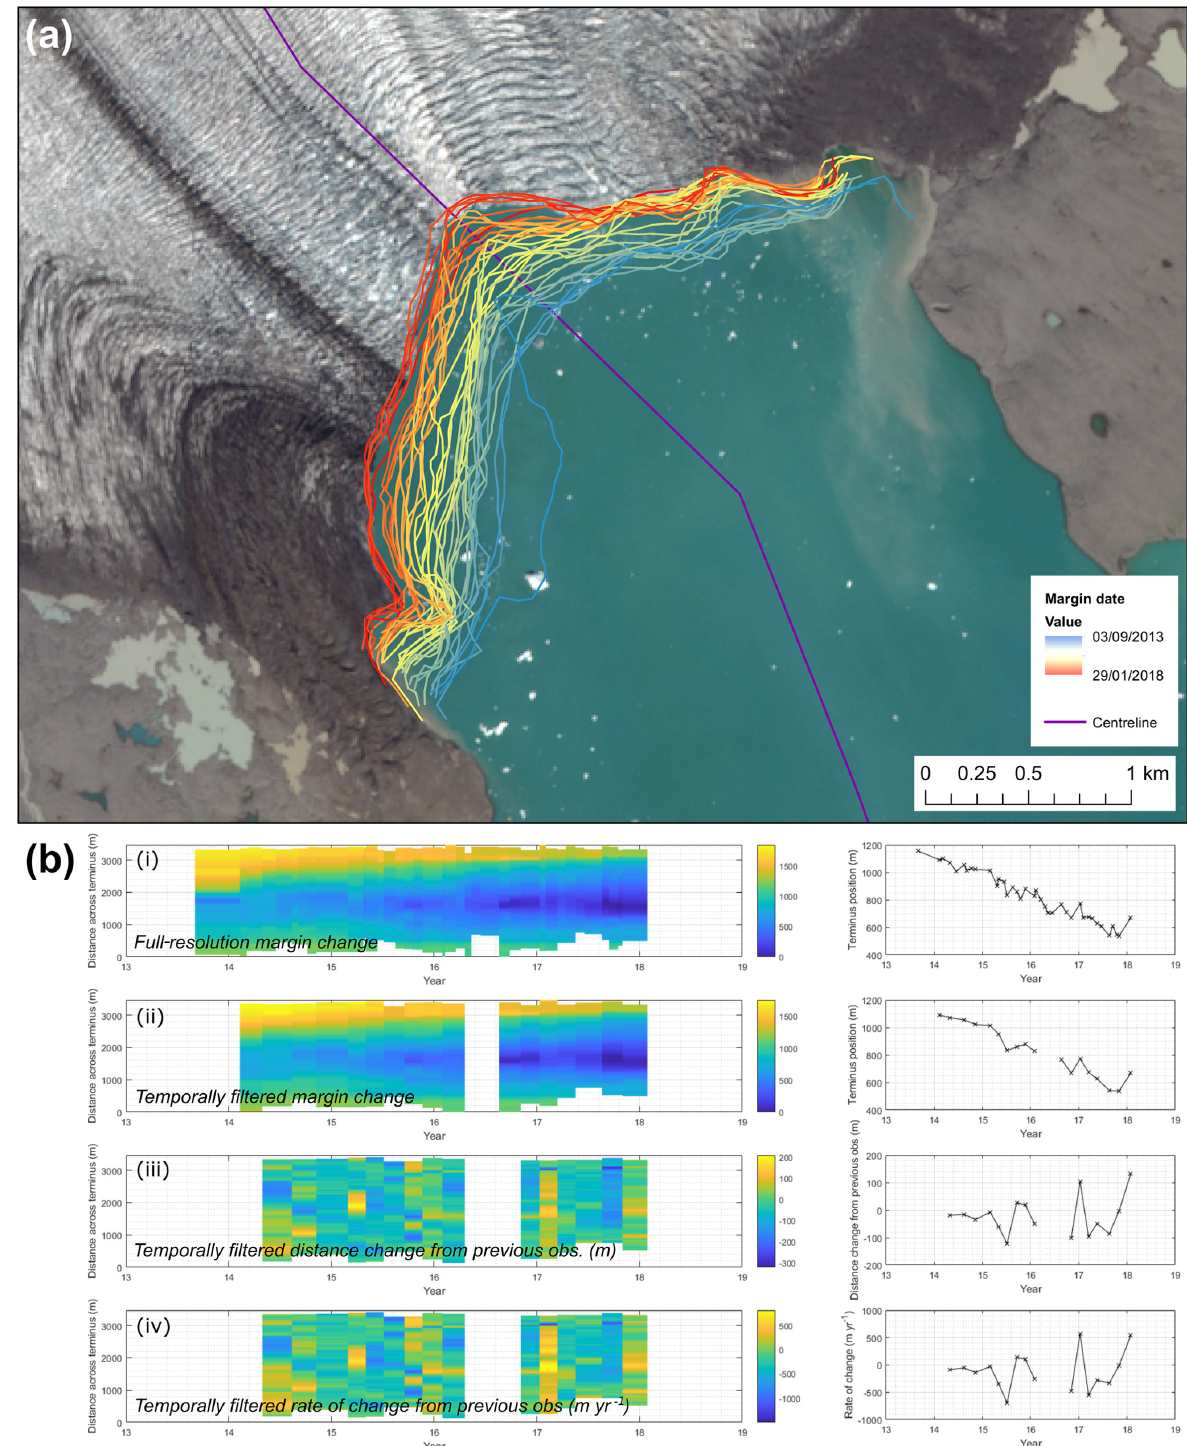
Figure 5. Margin migration for monthly Landsat 8 observations of Breiðamerkurjökull shown as a time series (a) cartographically and (b) as results from the multi-centreline method. Panel (b) has four rows of plots showing (i) the margin position for all available observations relative to the most retreated position across the margin; (ii) margin position observations separated by at least 60 days and a maximum of 120 days (these values are user-defined); (iii) total distance change between observations; and (iv) rate of change of margin in myr − 1 . Right-hand column of plots displays results of the centreline method for